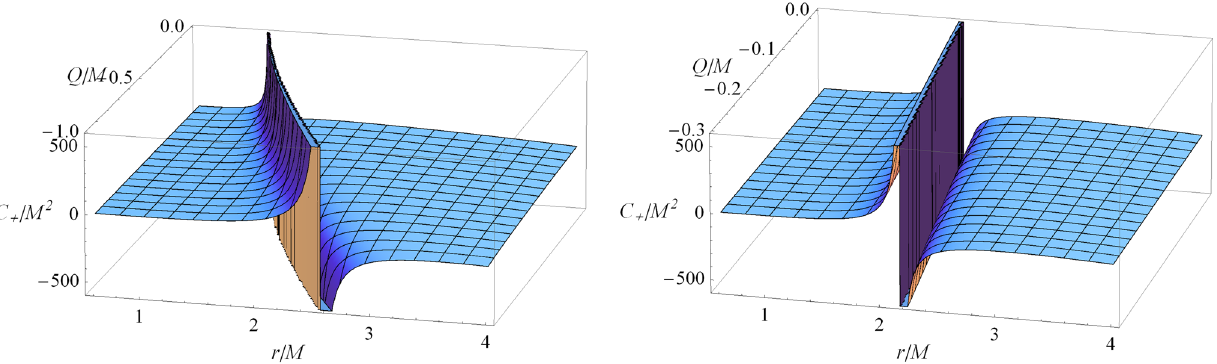
Fig. 6 Plots of C + vs radius r + and hair Q for a = 0 . 6 M and 0 . 9